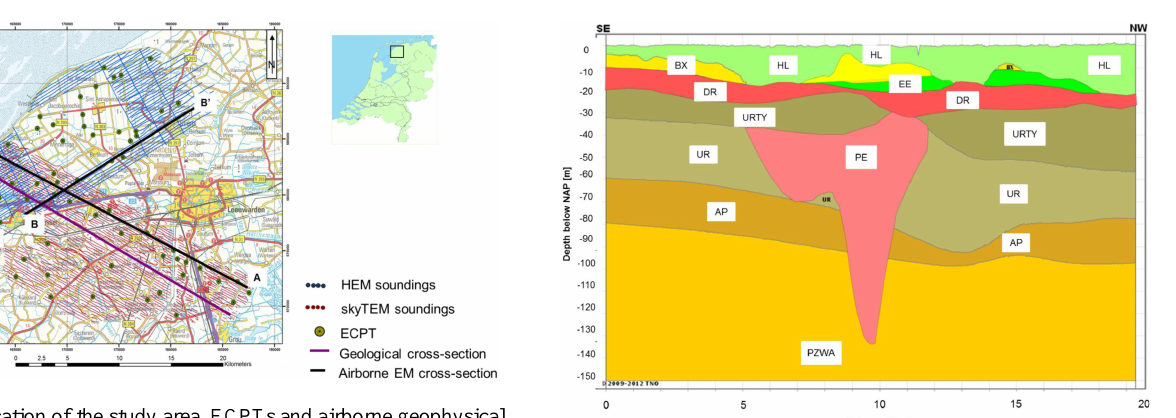
Fig. 1. Location of the study area, ECPTs and airborne geophysical data.